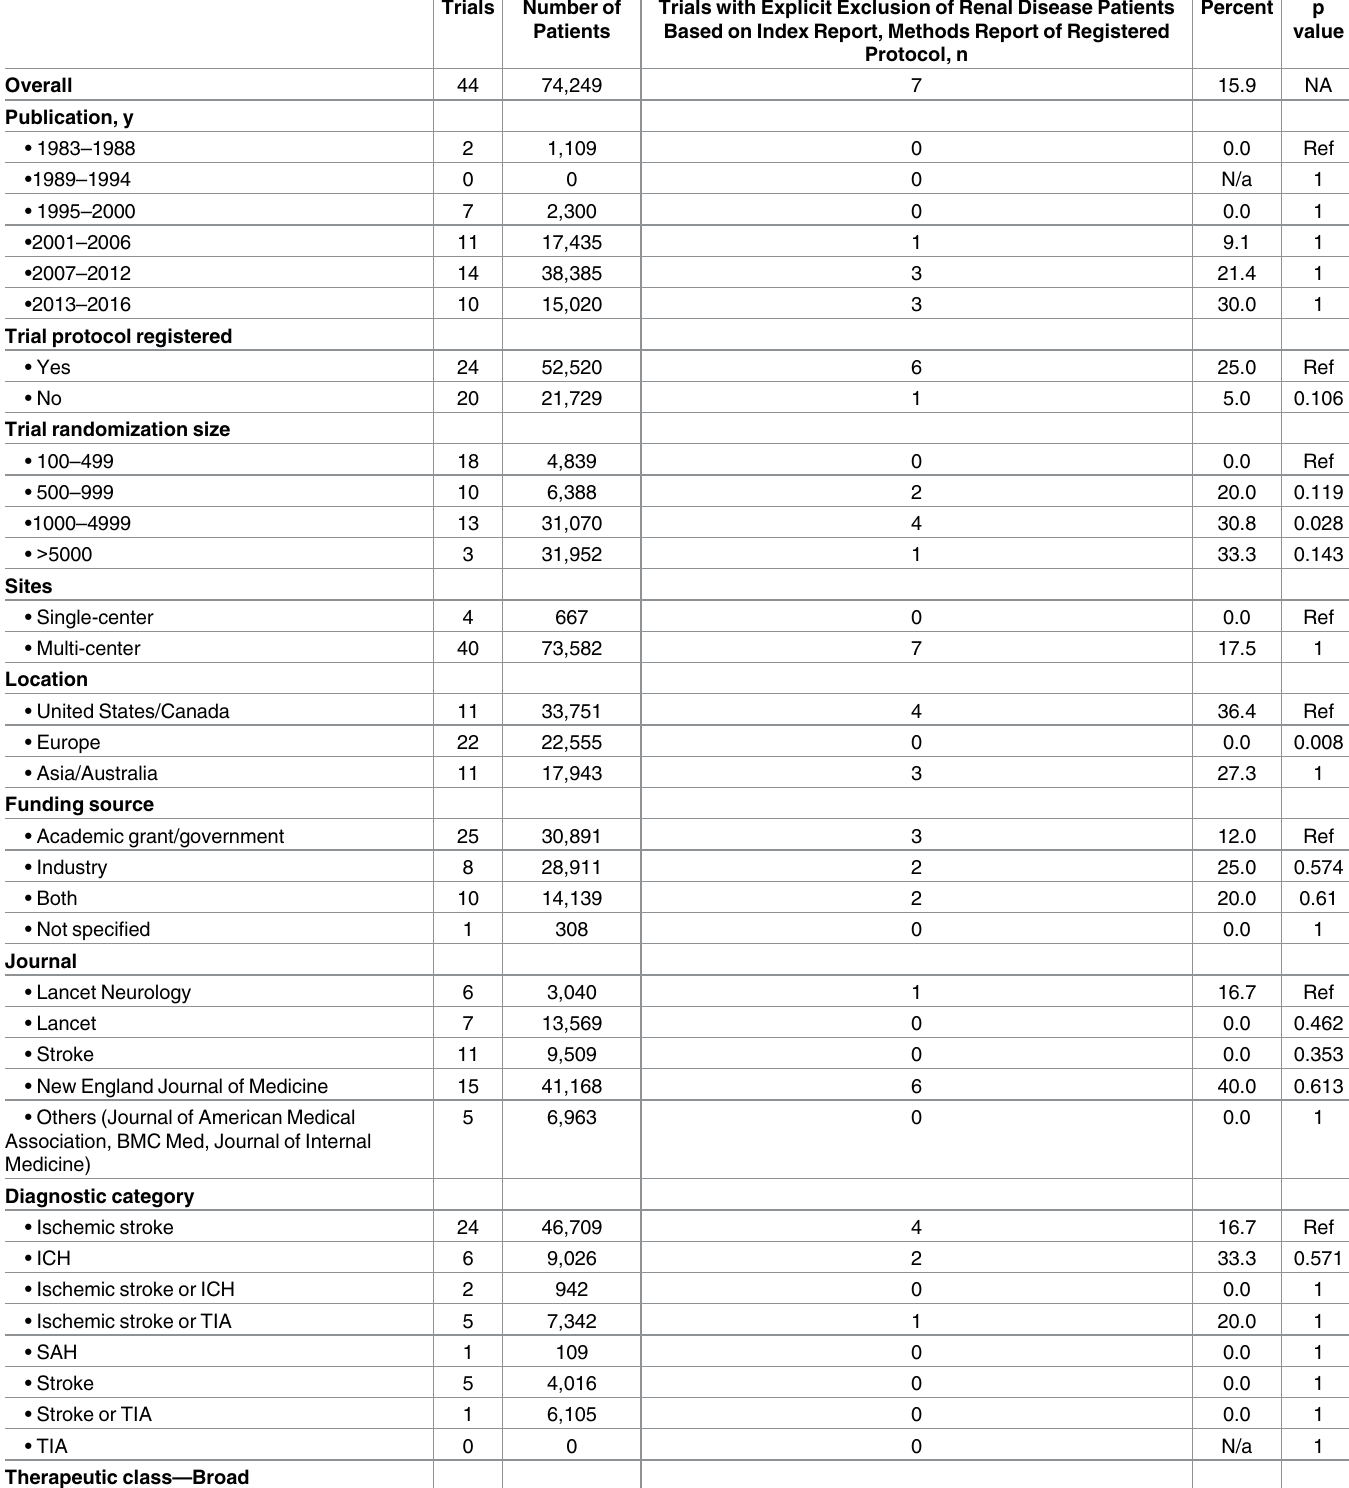
Table 3. Characteristics of cerebrovascular trials of class I/II treatment